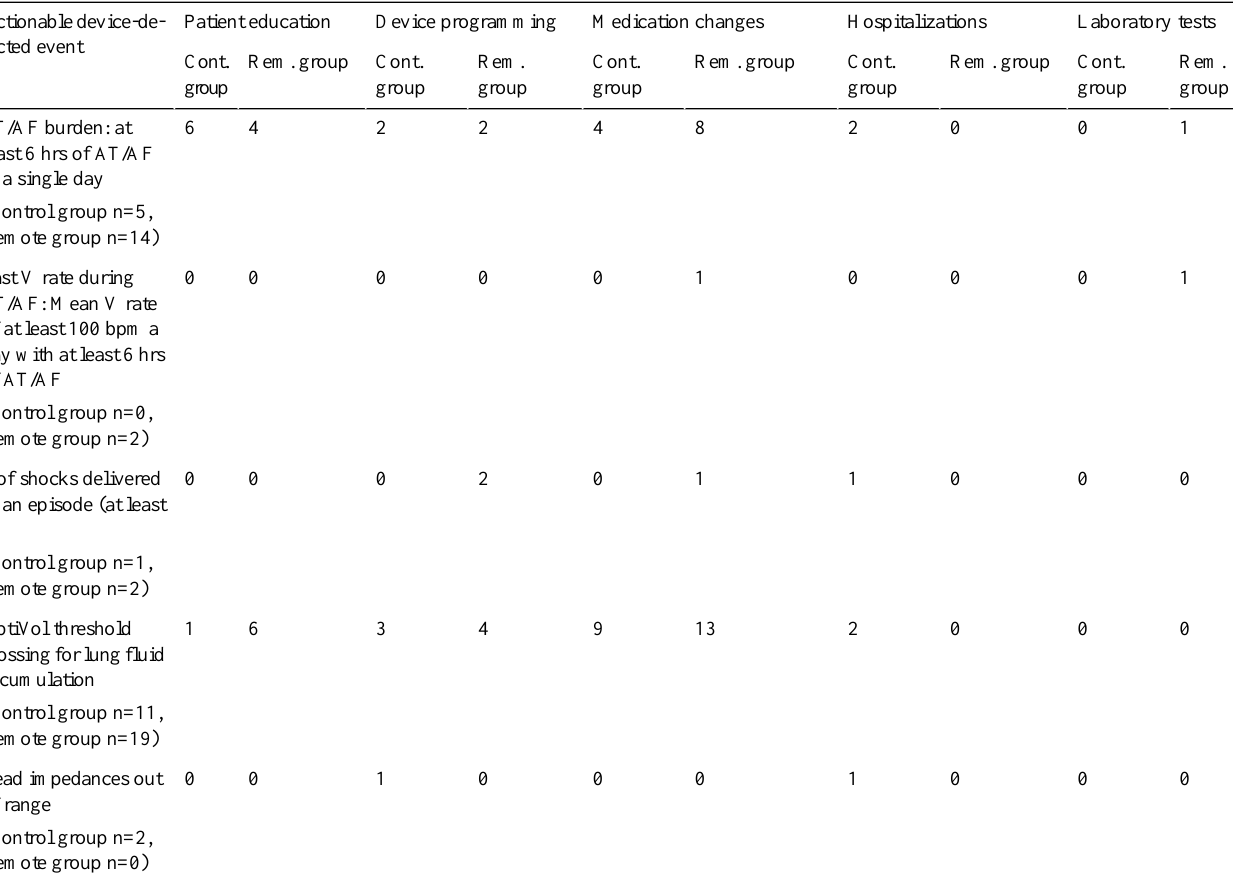
Table 4. Distribution of clinical actions among all actionable device-detected events (19 in the Control group and 37 in the Remote group) followed by a clinical